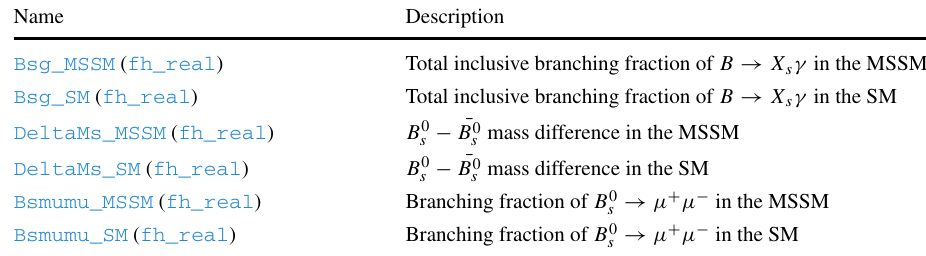
Table 5 Flavour observables contained in the fh_FlavourObs structure obtained from FeynHiggs